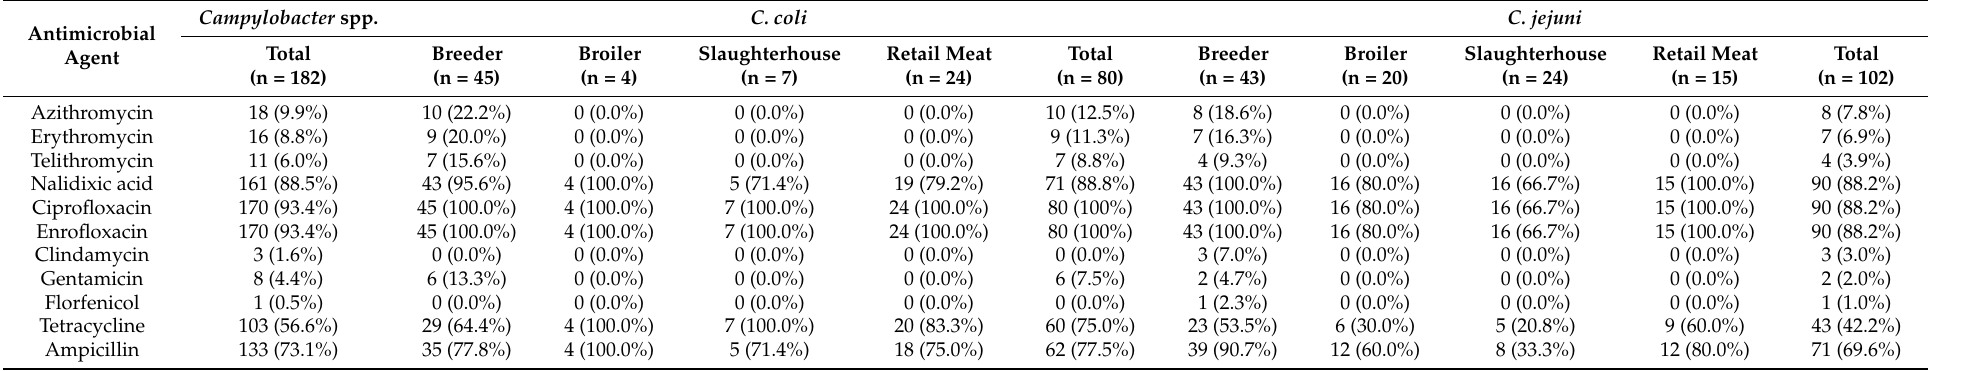
Table 2. Antimicrobial resistance profiles of Campylobacter isolates from the chicken production chain. Antimicrobial